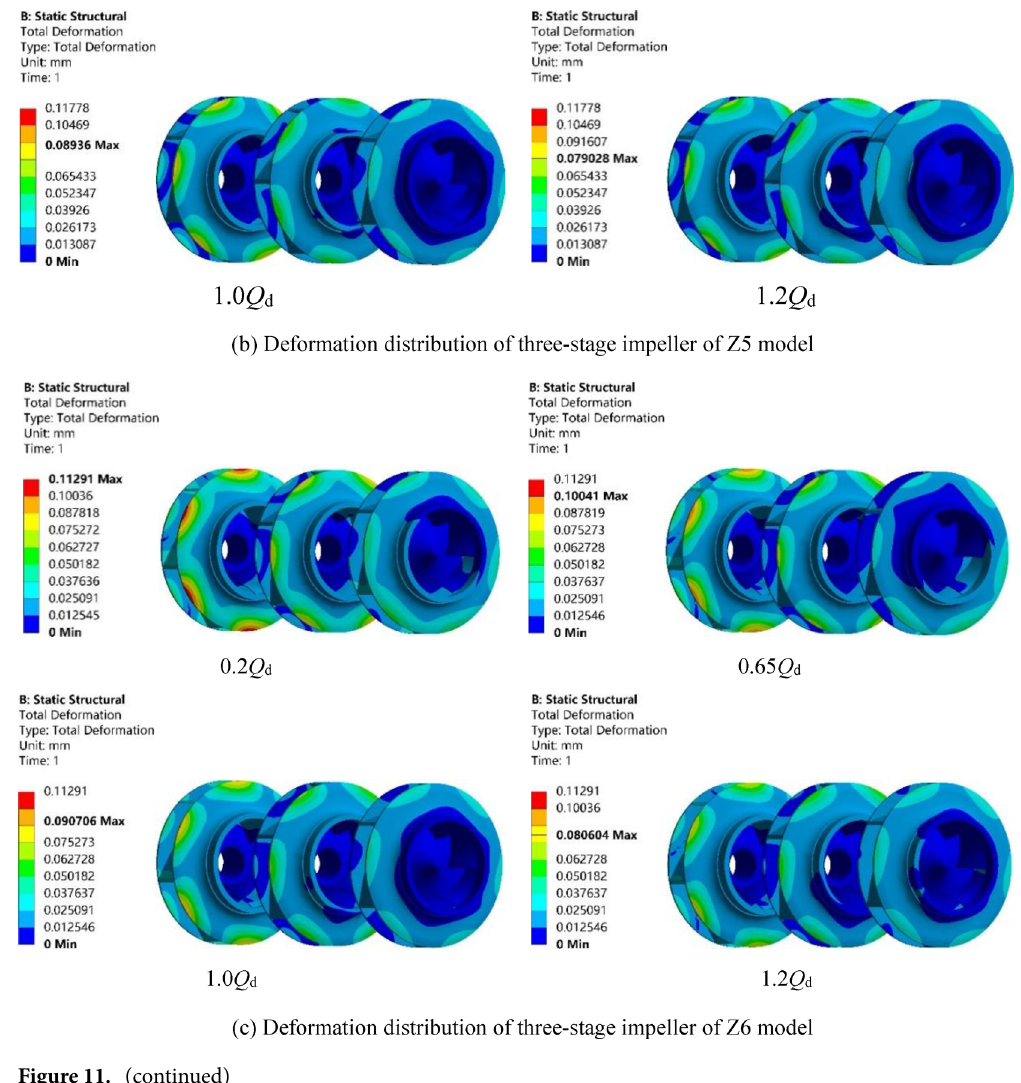
Figure 11. force. Figure 10f shows the support setting of the rotor model, in which the “Cylindrical Supports” are represented by the letters “A-I” and the Remote Displacement is represented by the letter “J”. The settings of the above loads and supports effectively ensure the consistency between the static calculation and the actual operating state of the rotor. In addition, factors such as gyro torque and sudden load changes have little effect on the results of rotor statics, which are not considered in this paper. Rotor deformation. Figure 11a–c show the deformation distributions of Z4, Z5 and Z6 models under the four working conditions of 0.2 Q d , 0.65 Q d , 1.0 Q d and 1.2 Q d . The three impellers in the figures are called first-, second- and third-stage impeller from right to left, respectively (same below). According to the fluid–structure interaction theory, due to the action of fluid load on the impeller, the deformation of the rotor mainly occurs on the impeller. As shown in the figure, the deformation of the impeller increases as the number of impeller stage increases, and the maximum deformation occurs at the upper crown edge of the third-stage impeller. The reason is that the fluid gained energy due to the rotation of the impeller, and hence the more stages the fluid passes through the impeller, the more energy it obtains. Therefore, the fluid pressure on the first-stage impeller is the smallest, and as the number of the impeller stages increases, the fluid pressure on the impeller gradually increases. In addition, as the flow rate increases, the overall pressure distribution of the impellers becomes more uniform, because the outlet pressure of the impeller under high flow conditions is lower than that under low flow conditions. With the increase of the flow rate, the deformation of the impeller was continuously reduced and becomes relatively more uniform. Such trend is basically consistent with that of the fluid pressure inside the impeller. Rotor equivalent stress. Figure 12a–c show the equivalent stress distribution of Z4, Z5 and Z6 models under the four working conditions of 0.2 Q d , 0.65 Q d , 1.0 Q d and 1.2 Q d . Because the impeller is subjected to fluid–